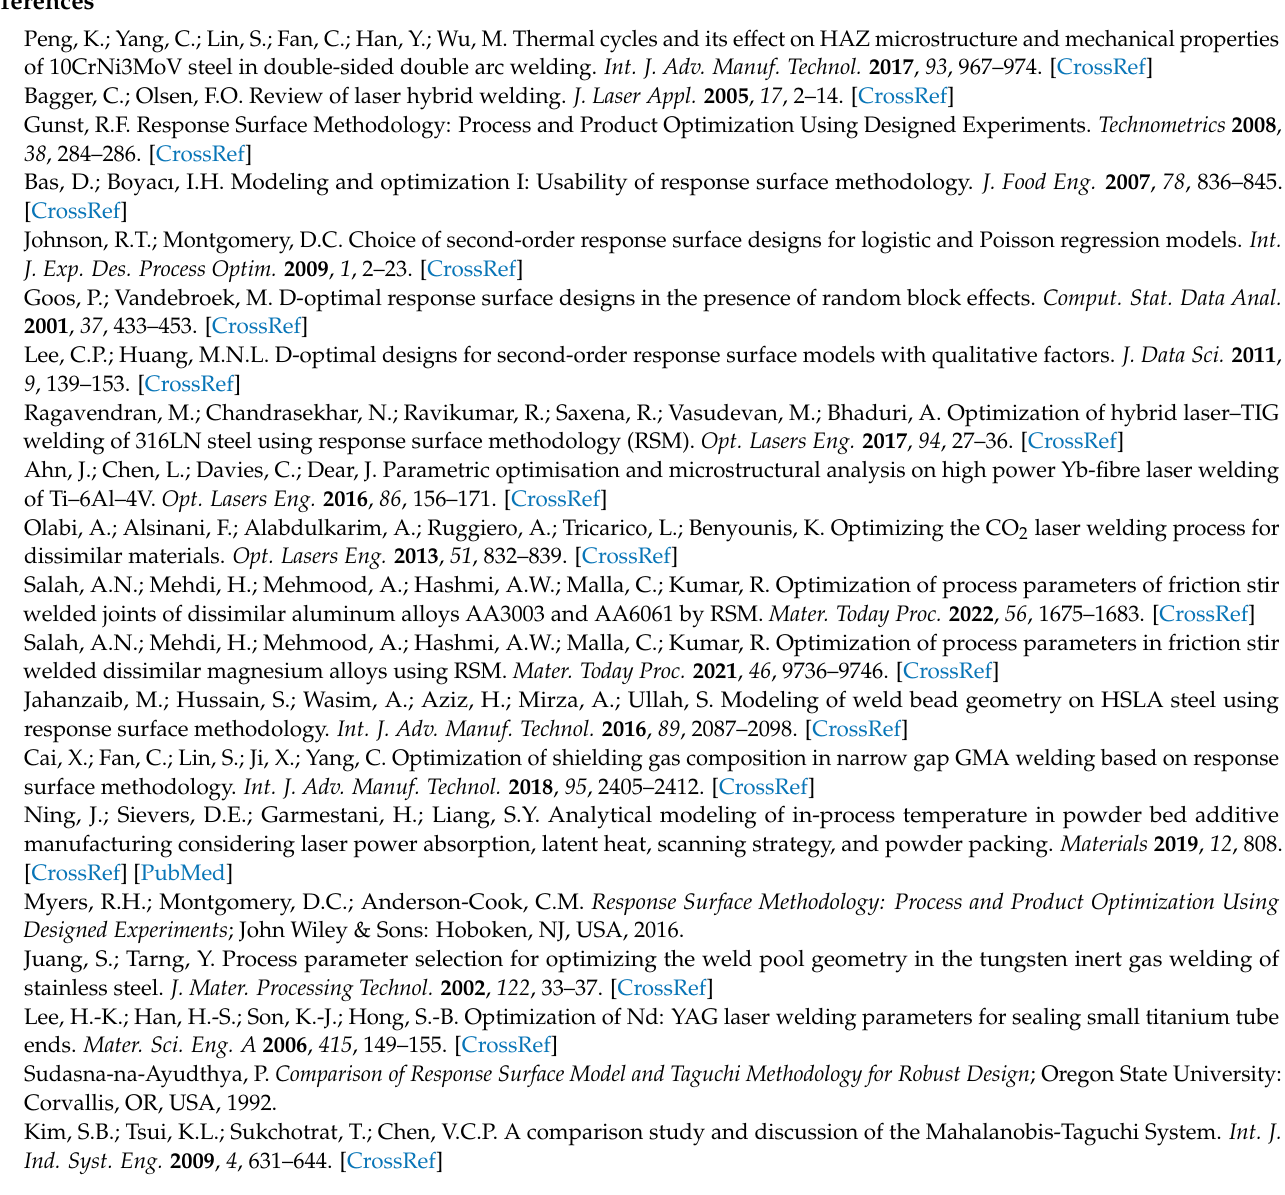
3. Optimal welding parameters: P = 3700 W, V = 0.8 m/min, Vs = 7 m/min. On the premise that the mechanical properties meet the inspection standards, the maximum penetration can reach nearly 8